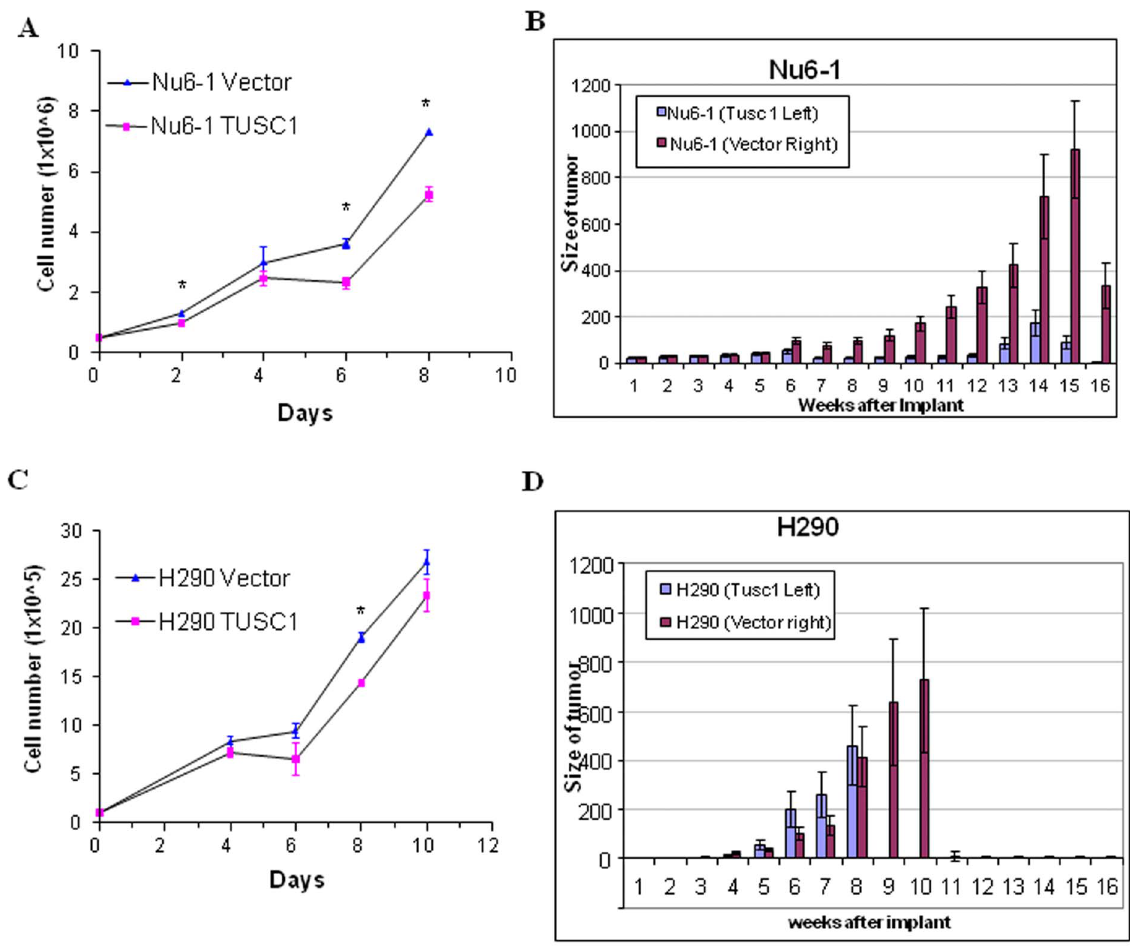
Figure 4. Overexpression of TUSC1 reduces cell growth and tumorigenicity of lung cancer cells. (A, B) In vitro cell growth of cancer cell lines (Nu6-1 and H290) transfected with TUSC1 . (C, D) Tumor volume of subcutaneously injected stably transfected cancer cells with TUSC1 in nude mice in vivo . Restoration of TUSC1 expression in cell lines with TUSC1 homozygous deletion suppressed cell growth and tumor development compared to the parental cell lines transfected with the empty vector (p , 0.05 ).